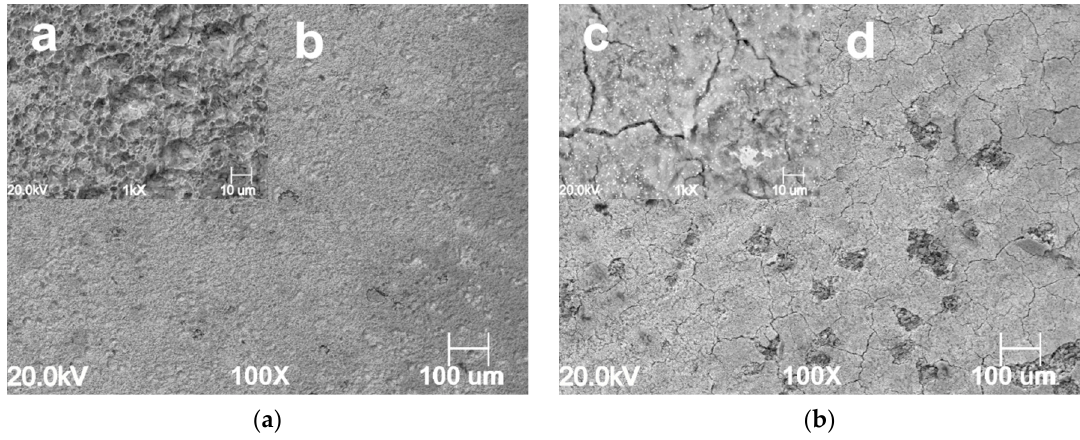
Figure 9. SEM images of the N80 carbon steel surface morphology after 24 h of immersion in the uninhibited (( a ) a lower and b higher magnification) and inhibited (( b ) c lower and d higher magnification) solution at 25 °C and P CO 2 = 40 bar CO 2 .